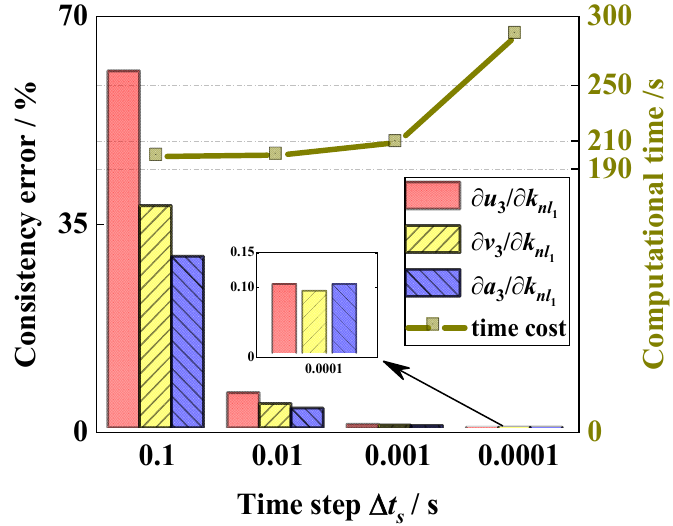
Figure 7. The accuracy and computational time of the sensitivities obtained from the DDM versus the different time steps.